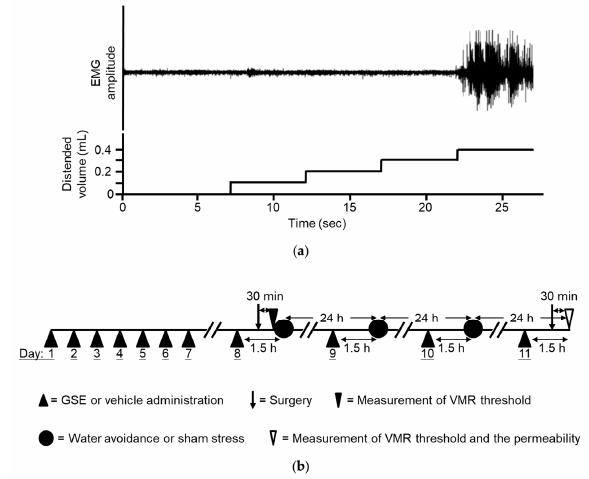
Figure 1. ( a ) Threshold of visceromotor response (VMR) determined by the distended balloon volume (mL) inducing apparent sustained abdominal muscle contractions. Demonstrable electromyogram (EMG) recording is depicted. The threshold of VMR was 0.4 mL in this rat. ( b ) Schematic representation of the experimental protocol. Grape seed extract (GSE) or vehicle was administered intragastrically once daily for 7 days. On the 8th day, GSE or vehicle was administered again, and 1 h later, surgical electrode implantation and insertion of a distension balloon into the distal colon were performed. The basal threshold of the VMR was analyzed 30 min after the surgery. The animals were then subjected to either WAS or sham stress for 1 h. The rats underwent this treatment, i.e., GSE or vehicle administration followed by a stress session, for 3 days. On the 11th day, the drug was administered and the analysis of the second threshold of VMR followed by the permeability test was conducted at 24 h after completing the last stress session. GSE, grape seed extract. VMR, visceromotor response, WAS, water avoidance stress. Middle colon tissues (1 cm in length) were washed and homogenized in PBS supplemented with Halt Protease and Phosphatase Inhibitor Cocktail (Thermo Fisher Scientific, Walthman, MA, USA). Protein concentrations were measured using the Bicinchoninic acid method (Thermo Fisher Scientific). Cytokine concentrations were analyzed using a V-PLEX Proinflammatory Panel 2 Rat Kit (Meso Scale Discovery, Gaithersburg, MD, USA), which is a highly sensitive multiplex enzyme- linked immunosorbent assay.